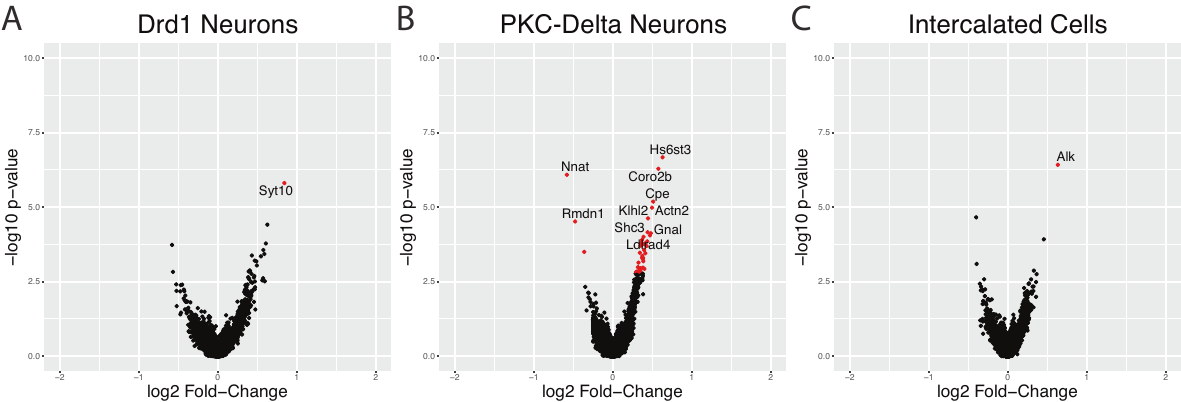
Fig. 4 Acute alcohol withdrawal is associated with differential gene expression in speci fi c subtypes of GABAergic neurons in the CeA. Volcano plots are shown for the three subtypes of GABAergic neurons with the greatest numbers of differentially expressed genes (Drd1 Neurons A , PKC δ neurons B , and intercalated cells C ). PKC δ cells have by far the greatest number of differentially expressed genes. Genes in red indicate differential expression based on adjusted p values of <0.05, and a log2 FC of >±0.25. The top ten differentially expressed genes are